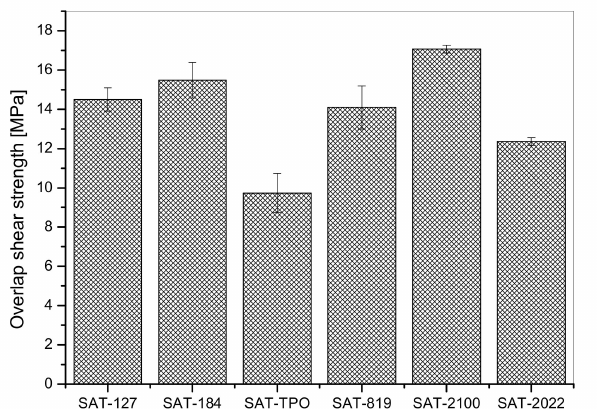
Figure 6. Shear strength for thermally cured aluminum–SAT–aluminum overlap joints.